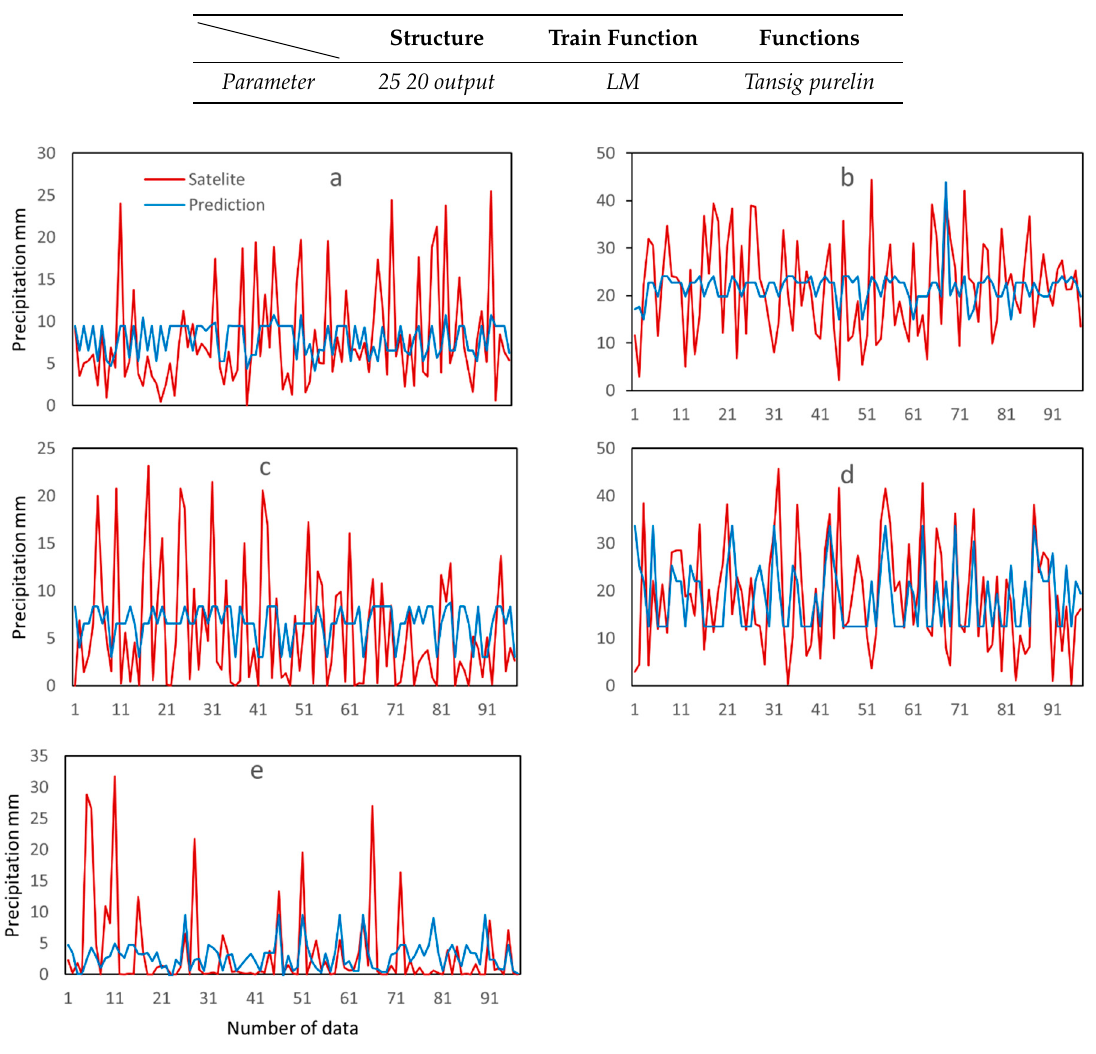
Table 2. Characteristics of the artificial neural network (ANN).